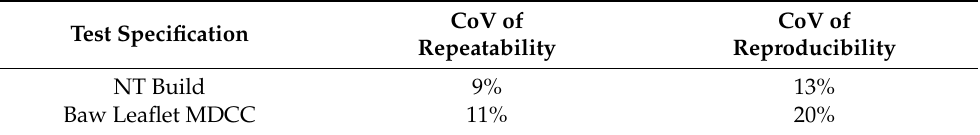
Table 1. CoV of repeatability and of reproducibility suggested by certain test specifications to evaluate scatter of D nssm -values for OPC-concrete